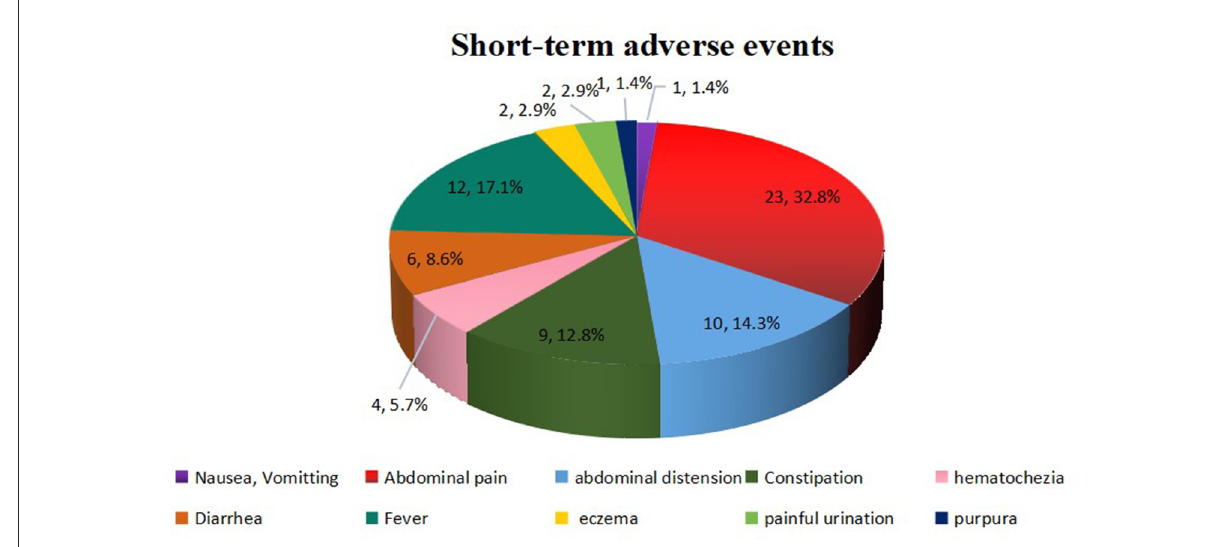
FIGURE2 FMT-related short-term AEs. Overall, 70 AEs were observed in 508 FMT courses. These AEs included abdominal pain ( n = 23), fever ( n = 12), abdominal distension ( n = 10), constipation ( n = 9), diarrhea ( n = 6), hematochezia ( n = 4), eczema ( n = 2), painful urination ( n = 2), nausea or vomiting ( n = 1), and purpura ( n = 1). FMT, fecal microbiota transplantation; AEs, adverse events.